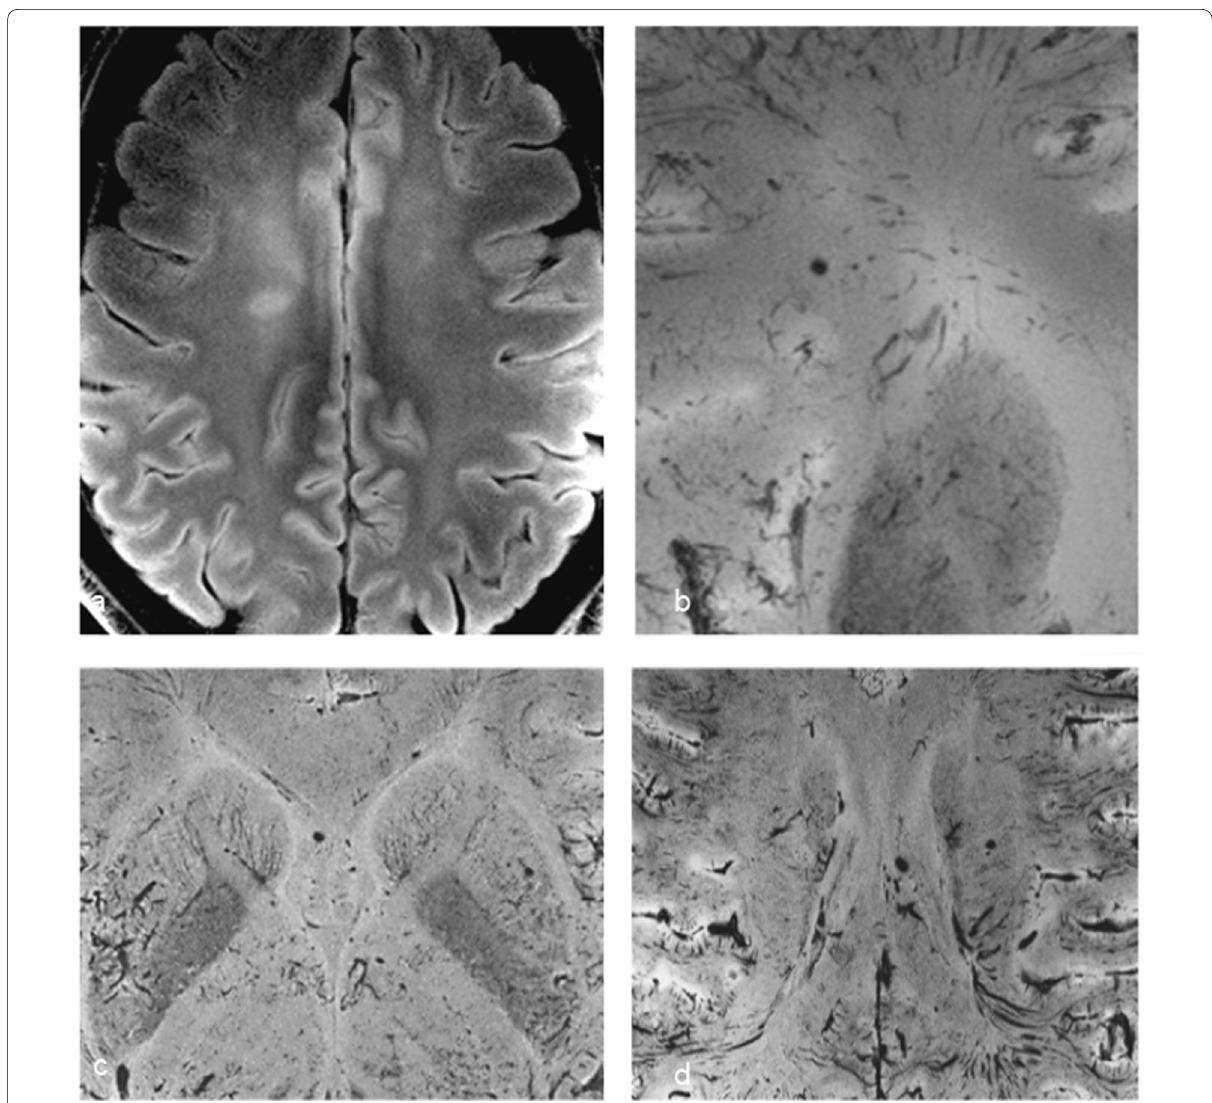
Fig. 5 Nonspecific multifocal white matter abnormalities with increased signal on FLAIR ( a ) and punctate hemorrhagic foci in the right white matter on SWI ( b ) of patient 5. Patient 7 showed some periventricular punctate hemorrhagic foci on SWI ( c , d